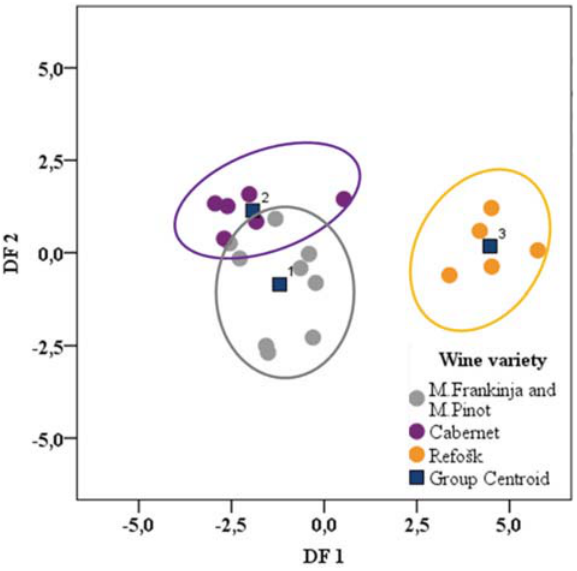
Figure 3. Graphic output of LDA in the plane of the first two dis- criminant functions. Classification according to